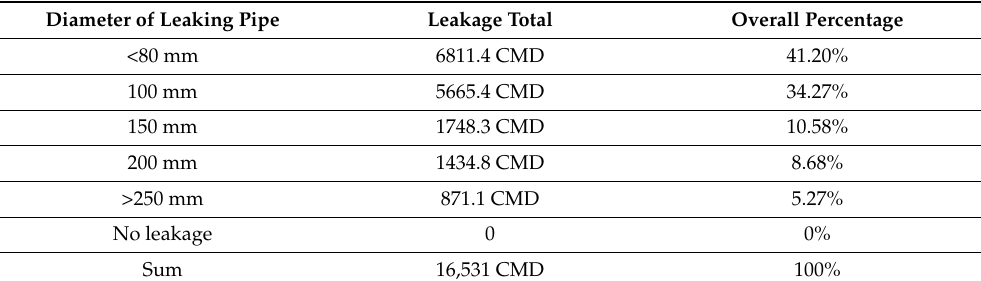
Table 3. Localized AI water leakage diagnostic instrument excavation and verification of leakage statistics of each pipe diameter.